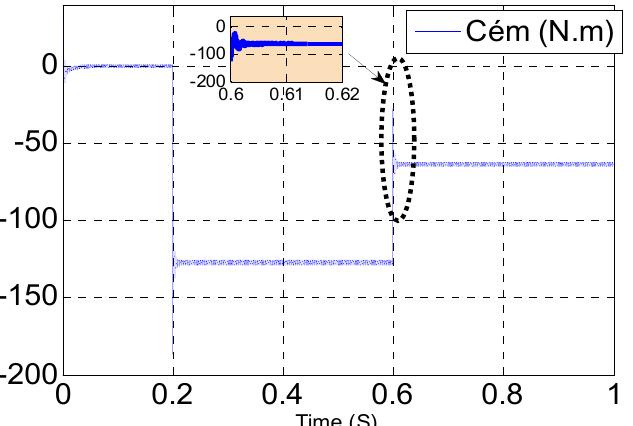
Figure 17. Electromagnetic torque.